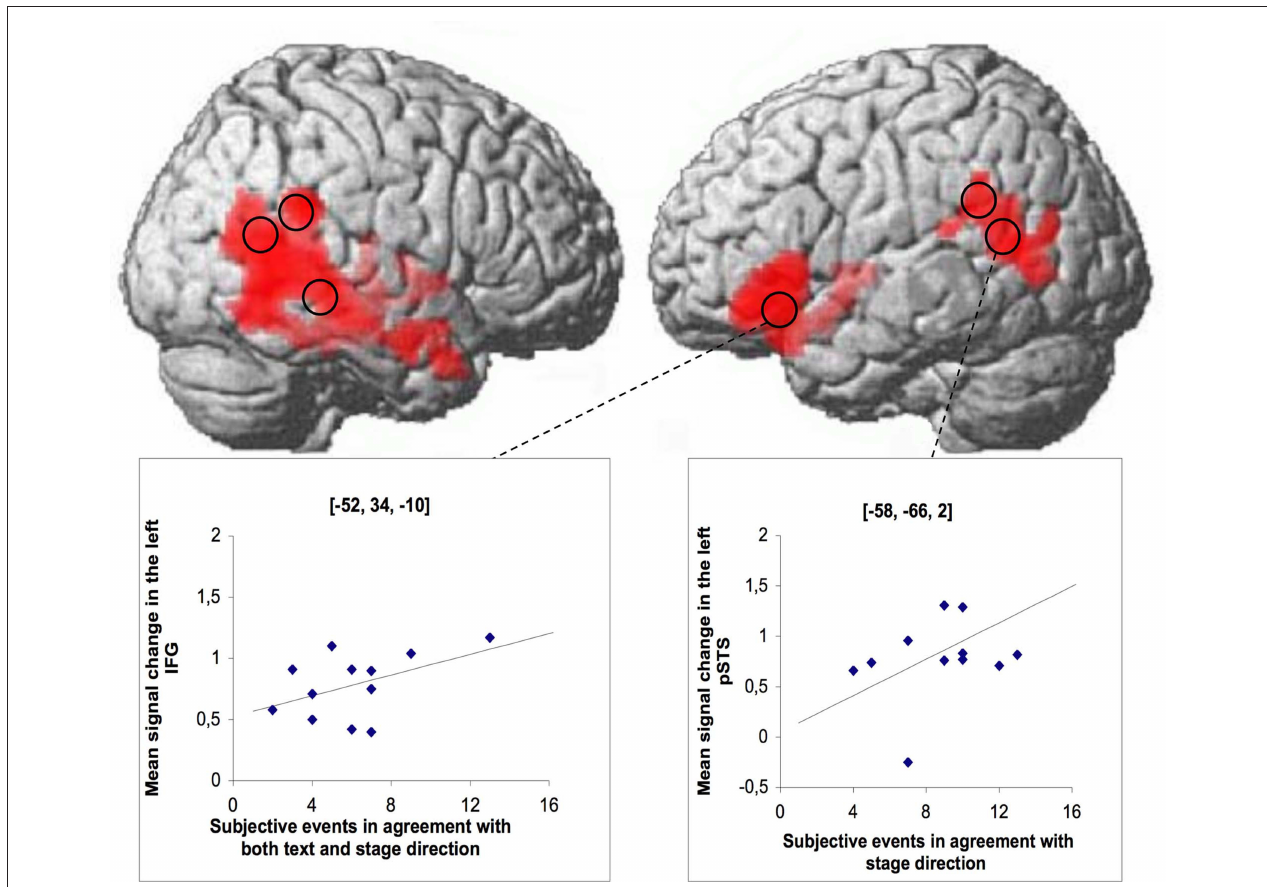
regions of interest circumscribed by black circles. Encapsulated figures : A significant positive correlation between activation in response to theatrical events and the adhesion rate was only found in the left anterior IFG for subjective responses related to both text- and direction-related markers, and in the left pSTS for subjective responses related to direction markers. The co-ordinates in brackets are those of the ROI